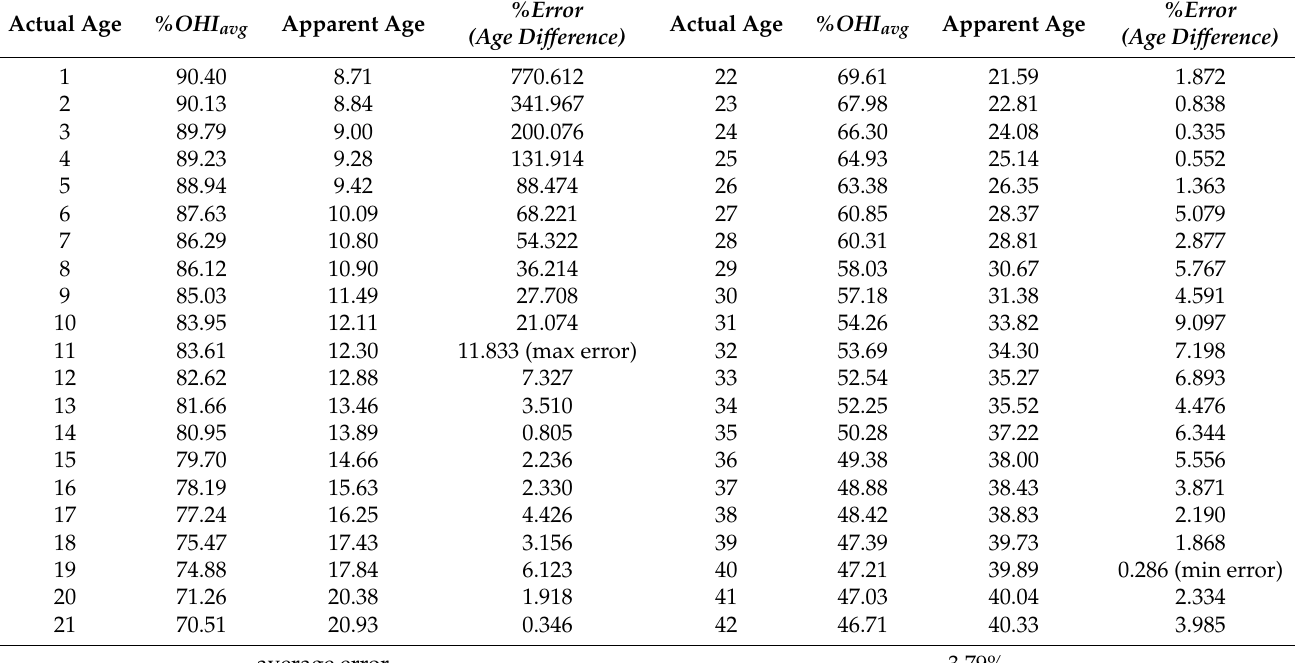
Table 7. RUL estimation error of the example retired